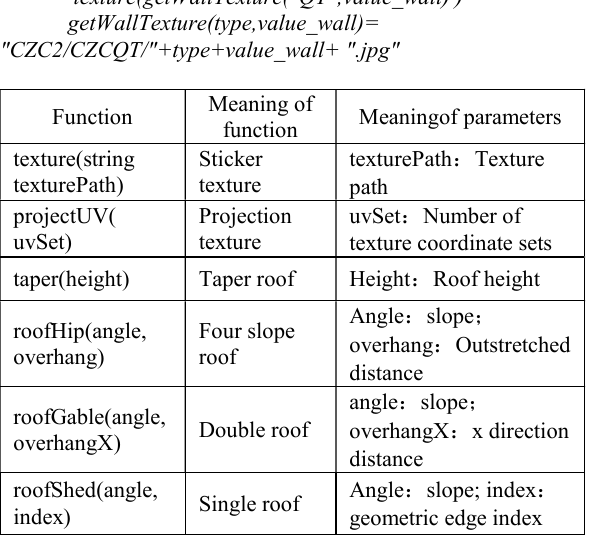
Table 3. The main functions of creating building